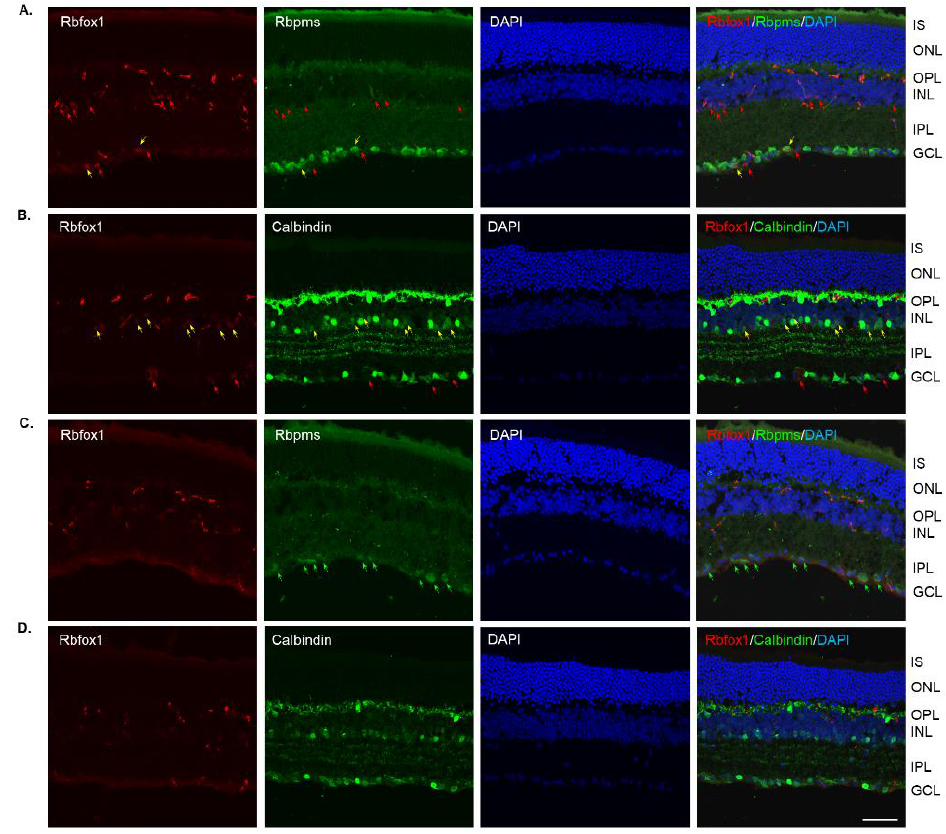
Figure 3. Downregulation of Rbfox1 expression in aged Rbfox1 KO animals. ( A – D ). The number of Rbfox1 positive cells and the immunostaining intensity in the few remaining Rbfox1-positive cells were dramatically decreased in retinas of both uninjured and ONC animals. Very few Rbfox1-positive RGCs or ACs were present ( A , B ), respectively; yellow arrows). Red arrows point at Rbfox1-immunostained ACs and dACs ( A ) and RGCs ( B ). The number of RGCs, dACs and ACs in Rbfox1 KO animals appeared to be normal. ( C ) Significant loss of RGCs 1 week after ONC was observed. Some of the remaining RGCs are pointed with green arrows. ( D ). The pattern of calbindin immunostaining is unaffected by ONC, although, the staining intensity appears to be lower than that in uninjured retinas. IS, photoreceptor inner segments; ONL, outer nuclear layer; OPL, outer plexiform layer; INL, inner nuclear layer; IPL, inner plexiform layer; GCL, ganglion cell layer. Scale bar, 50 µm.